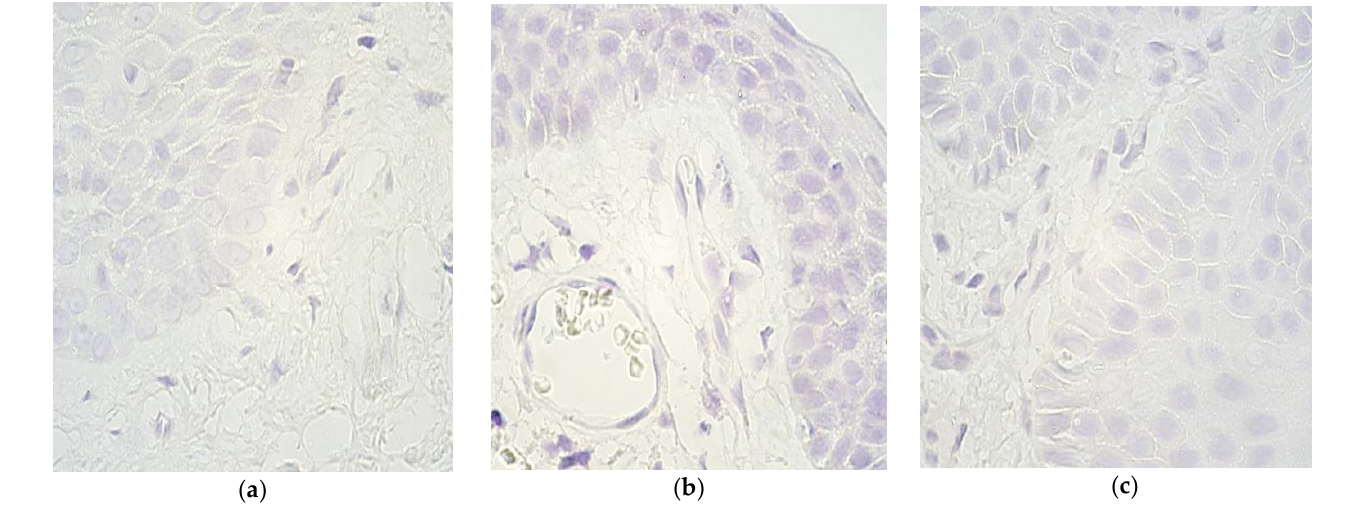
Figure 3. Chromogenic in situ hybridization micrographs of FOXO1 in cleft-affected lip and palatine tissue and control subject at 1000× magnification, using immersion oil. ( a ) No (0) gene signals in lip epithelium and connective tissue in a 3-month-old patient. ( b ) No (0) gene signals in palatine epithelium, connective tissue and endothelium in a 10-month-old patient. ( c ) No (0) gene signals in the control group epithelium and connective tissue of a 7-year-old child.